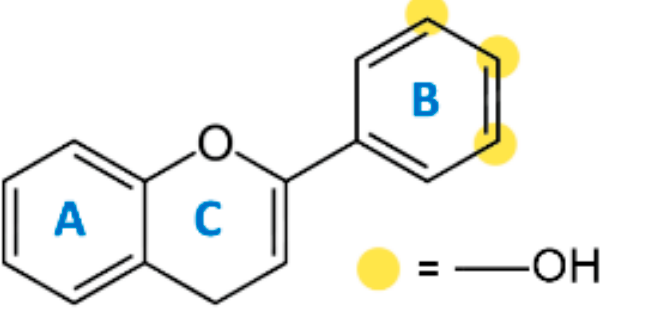
Figure 4. Flavonoid skeleton. The possible positions of the hydroxyl groups in the B-ring are high- lighted.